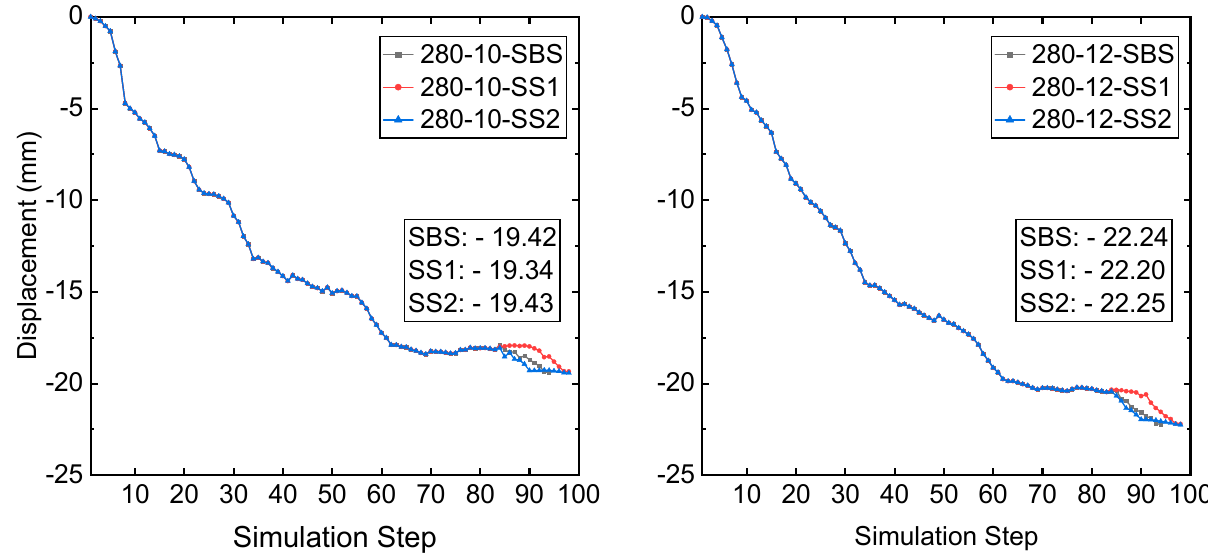
Figure 6. A comparison of displacement at monitored prism 280-10 and 280-12. The displacements at monitoring zone 1 and zone 2 are shown in Figure 7. Like the displacement at monitoring zone 3, the final displacements of three different recovery schemes are very close at both monitoring zone 1 and zone 2. At the prism CRF-S, the three displacements are − 48.49 mm, − 48.39 mm, and − 48.47 mm, respectively, from recovery schemes SBS, SS1, and SS2. The three displacements at the monitoring prism CRF-N are − 38.45 mm, − 38.38 mm, and − 38.44 mm, from recovery schemes SBS, SS1, and SS2, respectively.